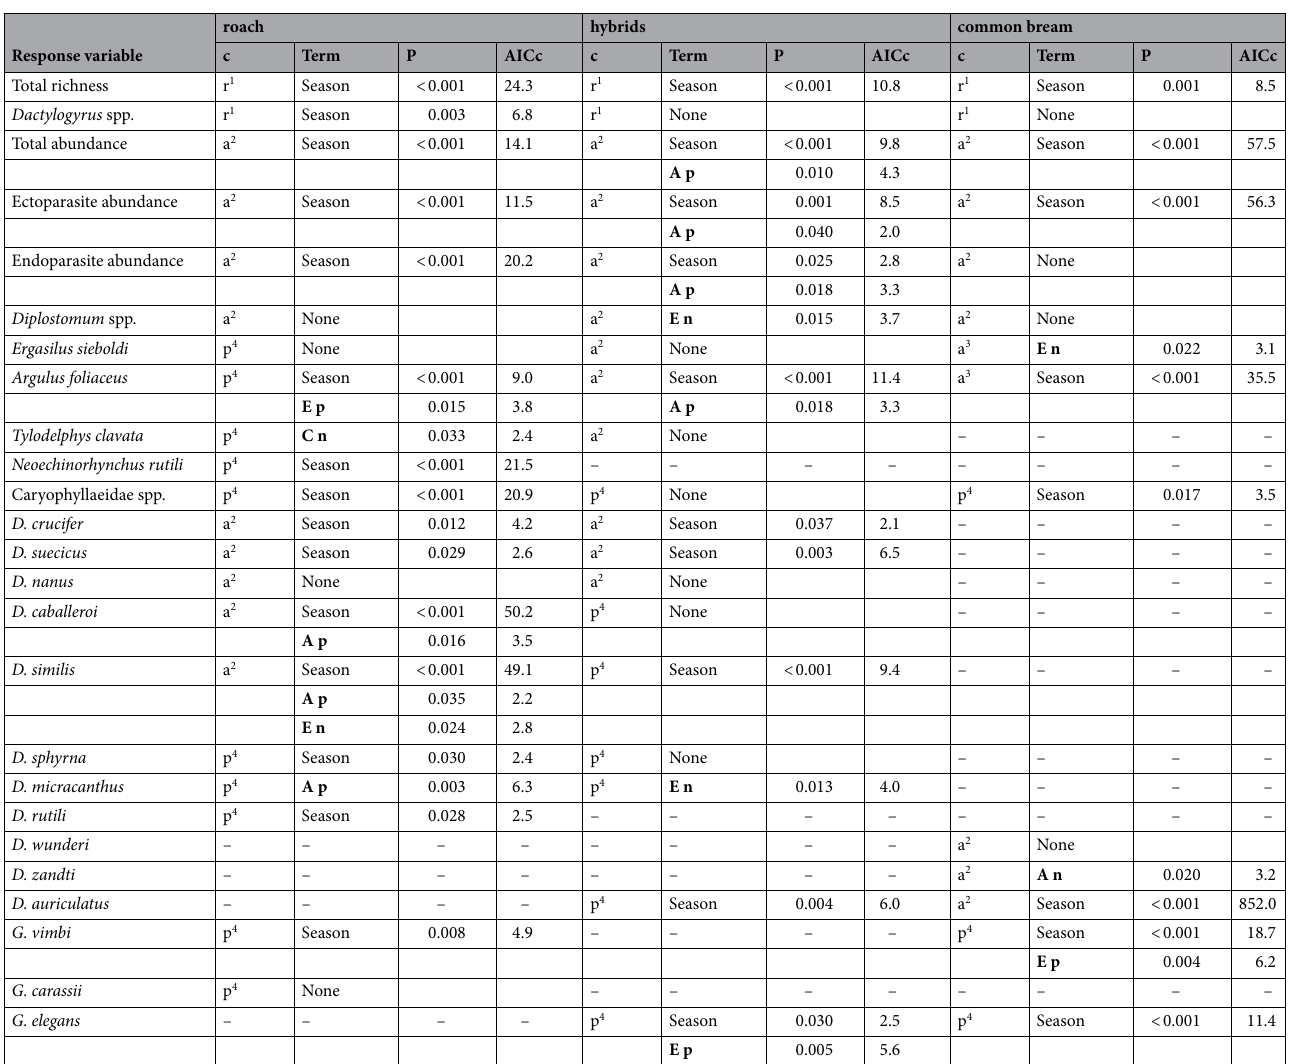
Table 6. Predictors remaining in final models originating by backward stepwise regression from GLMMs detecting effects of season and most common DAB allele supertypes on attributes describing parasitofauna of roach, common bream and their hybrids (richness, abundance or, in case of prevalence < 30%, prevalence was used instead of abundance). MHC supertypes that were a significant part of final models are in bold (p and n stands for positive and negative relationship with the response variable). c = characteristic studied: r = richness, a = abundance, p = prevalence; distribution as specified in the model: 1 Poisson, 2 negative binomial, 3 Poisson with observation level random effects, 4 Bernoulli. Full model predictors for roach: season + A + C + E . Full model predictors for common bream and hybrids: season + A + C + D +